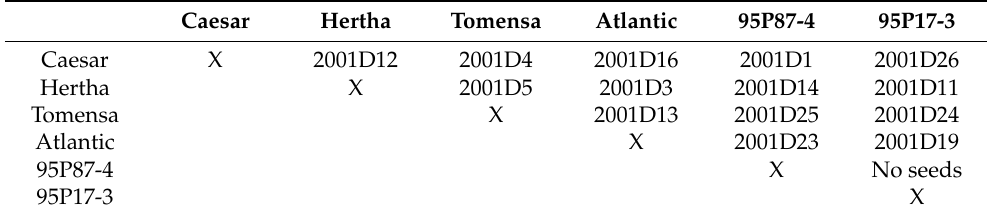
Table 2. Progenies obtained from crosses.